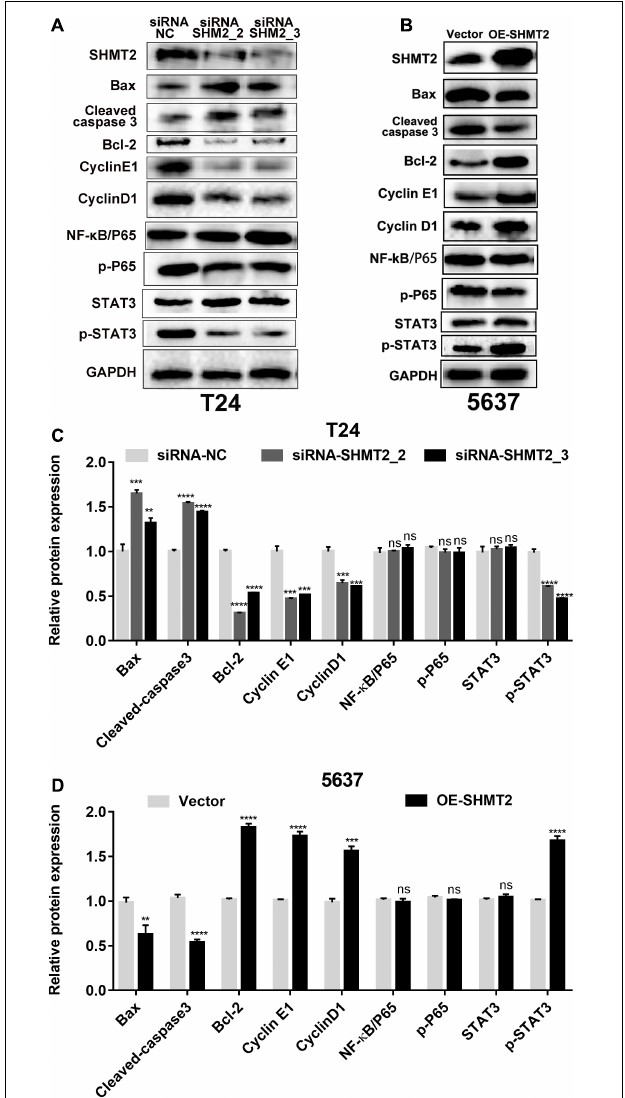
FIGURE 10 | Protein expression analysis of downstream of SHMT2. (A–D) Knockdown of SHMT2 increased the apoptotic protein expression levels of Bax and cleaved-caspase 3, but decreased the antiapoptotic protein expression levels of Bcl-2; overexpression of SHMT2 decreased the protein expression of Bax and cleaved-caspase 3, but increased the protein expression of Bcl-2. Knockdown of SHMT2 reduced the cell cycle-related protein expression levels of cyclin E1 and cyclin D1, overexpression of SHMT2 elevated the protein expression of cyclin E1 and cyclin D1. SHMT2 did not affect the expression of NF- κ B/P65, p-P65 and STAT3, knockdown of SHMT2 reduced the protein expression levels of p-STAT3, overexpression of SHMT2 elevated the protein expression levels of p-STAT3 ( n = 3; *** P < 0.001, **** P < 0.0001). P -value < 0.05 was recognized as statistically significant.